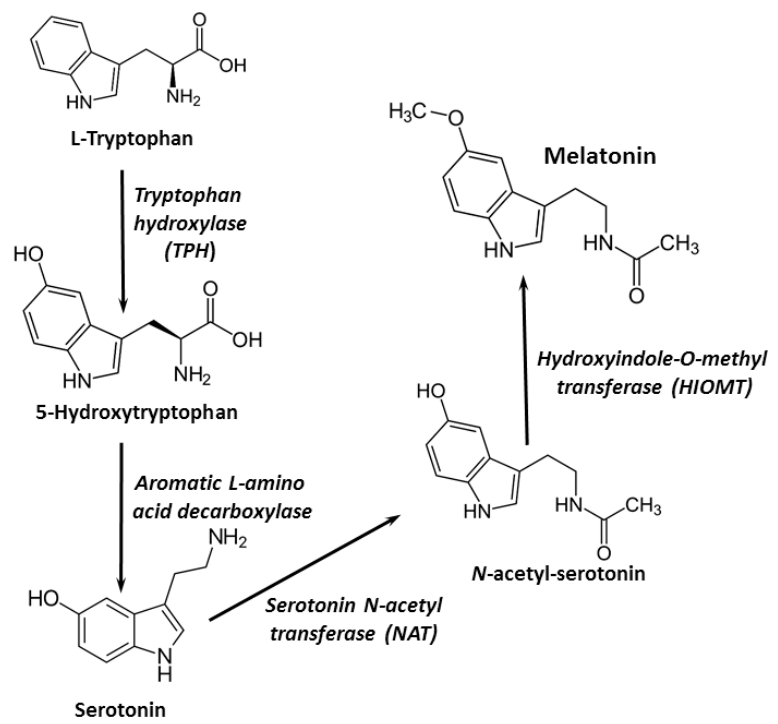
Figure 1. Melatonin synthesis pathways.